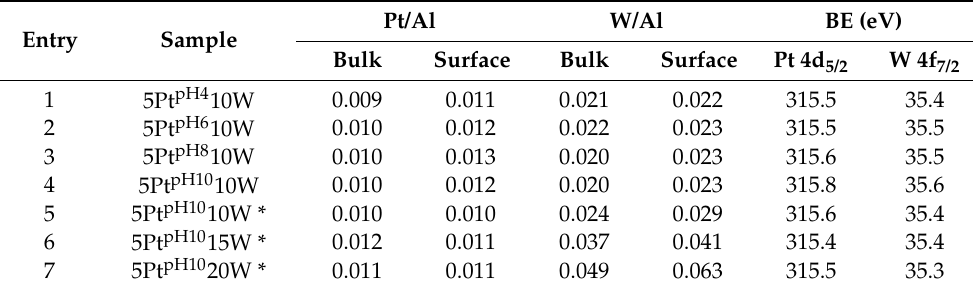
Table 2. Bulk atomic ratio obtained from ICP-AES, surface atomic ratio obtained from XPS and binding energies (BE) of the Pt and W elements for calcined Pt-WO x /Al 2 O 3 catalysts.